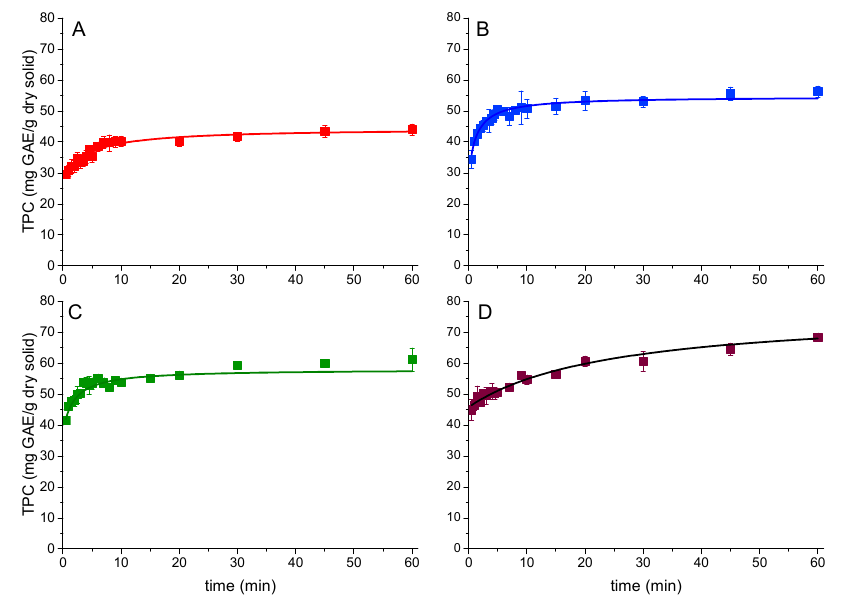
Figure 7. Kinetic analysis of the extraction process from grape pomace (GP) with a hydroalcoholic solution (ethanol/water 70%/30% v/v ) at several temperatures: ( A ) 25 °C, ( B ) 50 °C, ( C ) 70 °C, and ( D ) 90 °C. Data, in points, reflects the total phenolic content (TPC) obtained by the Folin–Ciocalteu method. The lines indicate the fitting of the second-order kinetic model presented in Equation (1).